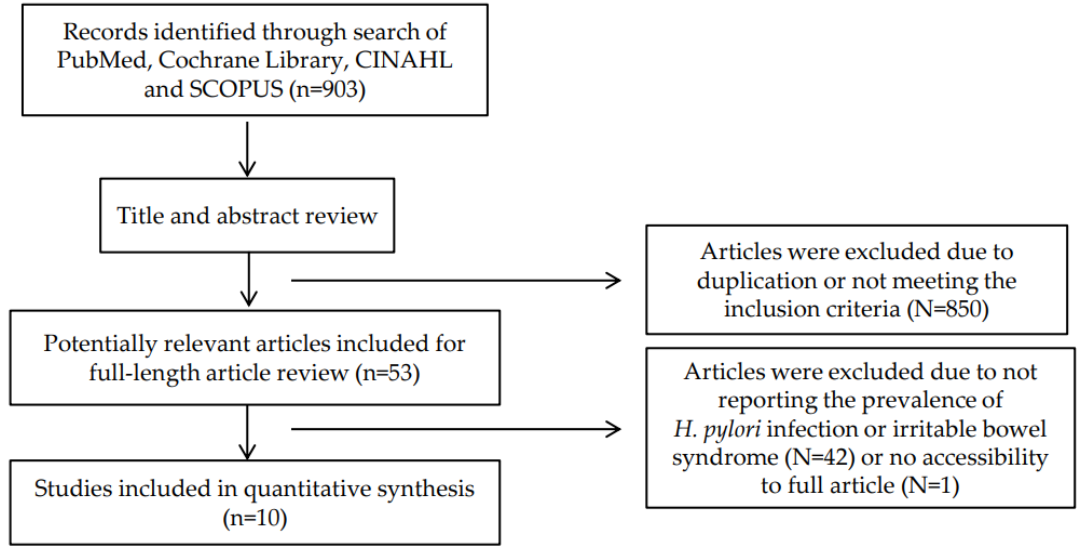
Figure 1. Flow chart of the search strategy.